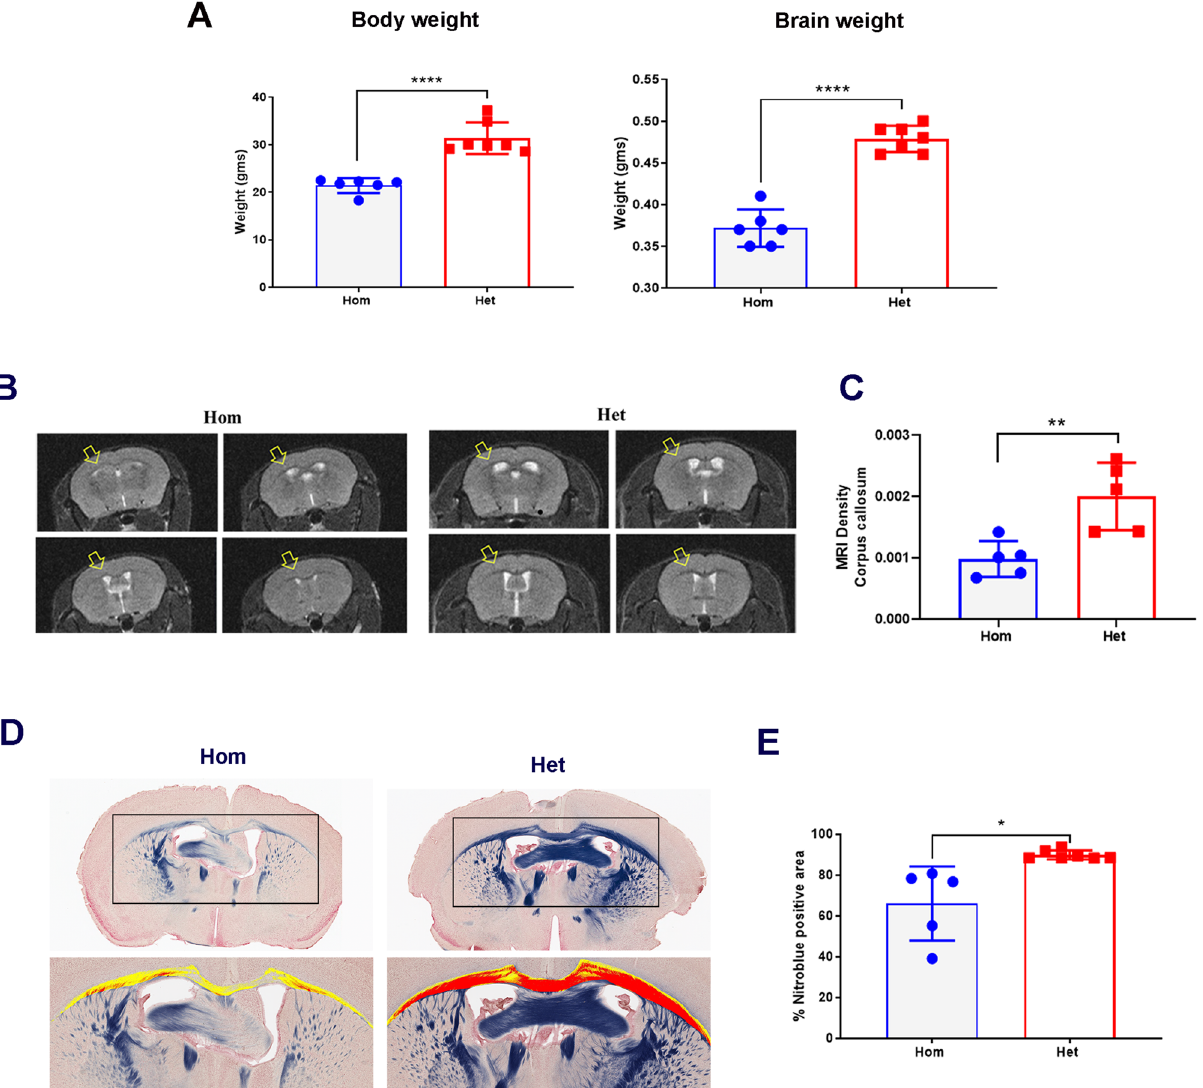
Figure 5. Brain and body weights and brain myelin changes in Hom and Het mice. ( A ) Summary of brain and body weights in 6-month-old Hom and Het mice. n = 6 Hom, 7 Het. ( B ) Representative MRI images showing corpus callosum density between Hom and Het mice. Note extensive distribution of the myelin change in Hom mouse. Each panel represents an individual animal at one time point. ( C ) Scatter plot shows MRI density in corpus callosum. n = 5 Hom, 5 Het. ( D ) Nitroblue stained representative images showing difference in myelin staining intensity in corpus callosum of 6-month-old Hom and Het mice. Note relatively pale blue intensity in the corpus callosum of a Hom mouse as compared to the Het mouse. Yellow (pseudo) color demonstrates sparse myelin content in corpus callosum of a Hom mouse when compared to the intense red representing dense myelin in corpus callosum of a Het mouse. Processed images annotated to include corpus callosum for signal quantitation using HALO2.2% area algorithm. Nitroblue stain. (4×). ( E ) Scatter plot shows % myelin positive area when compared to the Het mice. Nitroblue stained sections analyzed using HALO2.2% area algorithm. n = 6 Hom, 7 Het. The graphical data for ( A, C, E ) are represented as mean ± SD (**** p < 0.0001, ** p = 0.0065, * p =